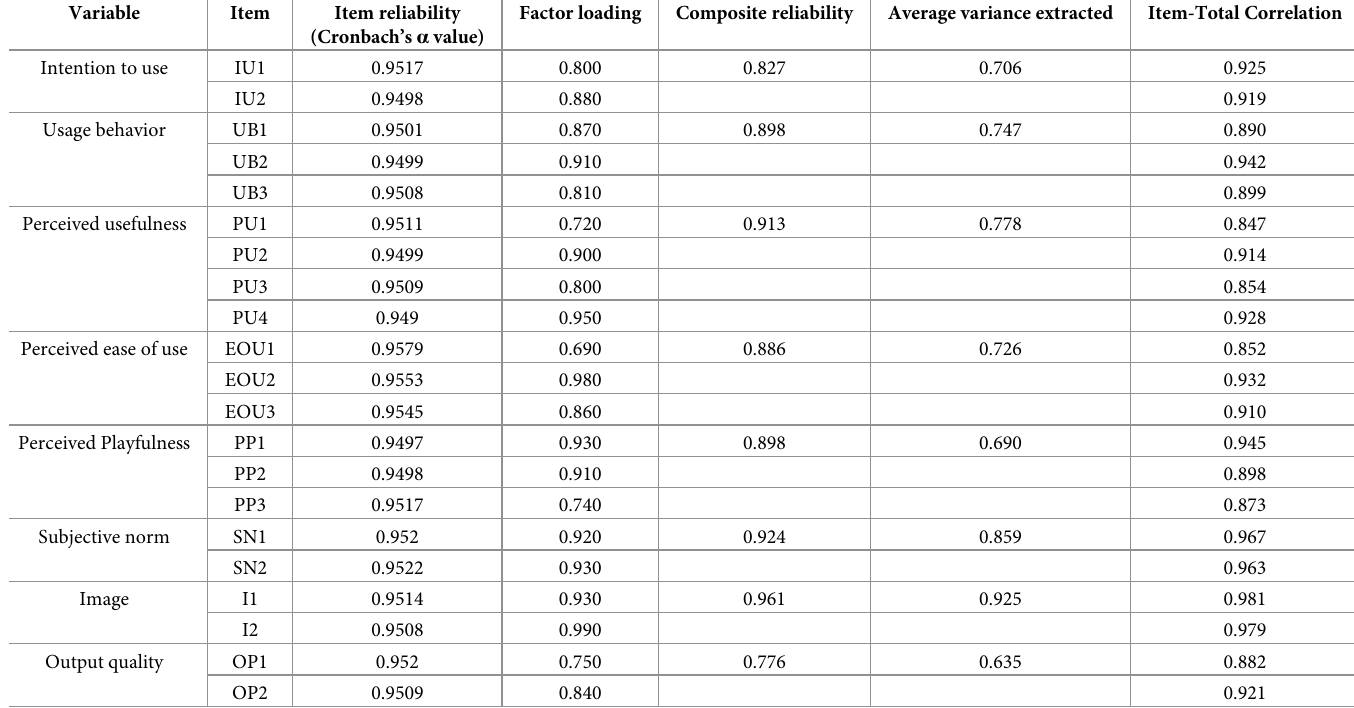
Table 4. Reliability and validity of measurement model for cognitive exergames.